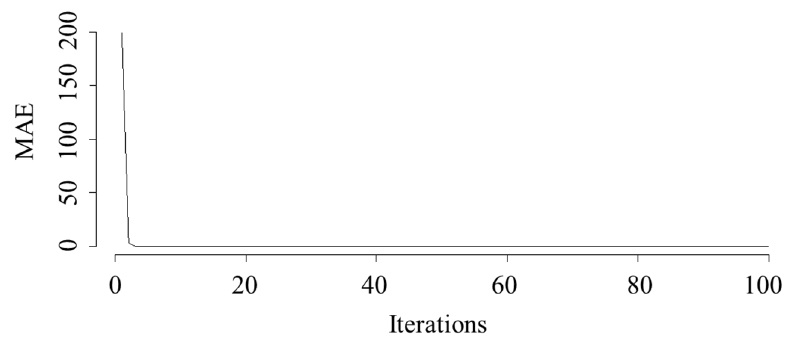
Figure 6. LSTM network